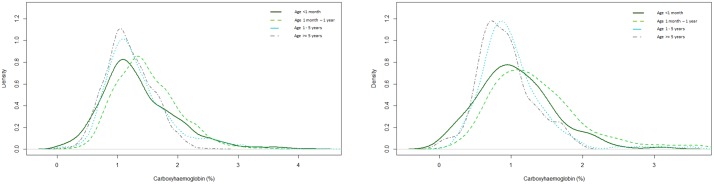
The distribution of (A) all carboxyhaemoglobin (COHb) values throughout PICU stay (left), and (B) the first measured value of COHb (right), according to age groups.There is a statistically significant difference between the groups for all COHb values (Kruskal-Wallis chi-squared 538.8; p-value <2 x 10−16) and first measured COHb values (Kruskal-Wallis chi-squared 47.1; p-value = 3.2 x 10−10).